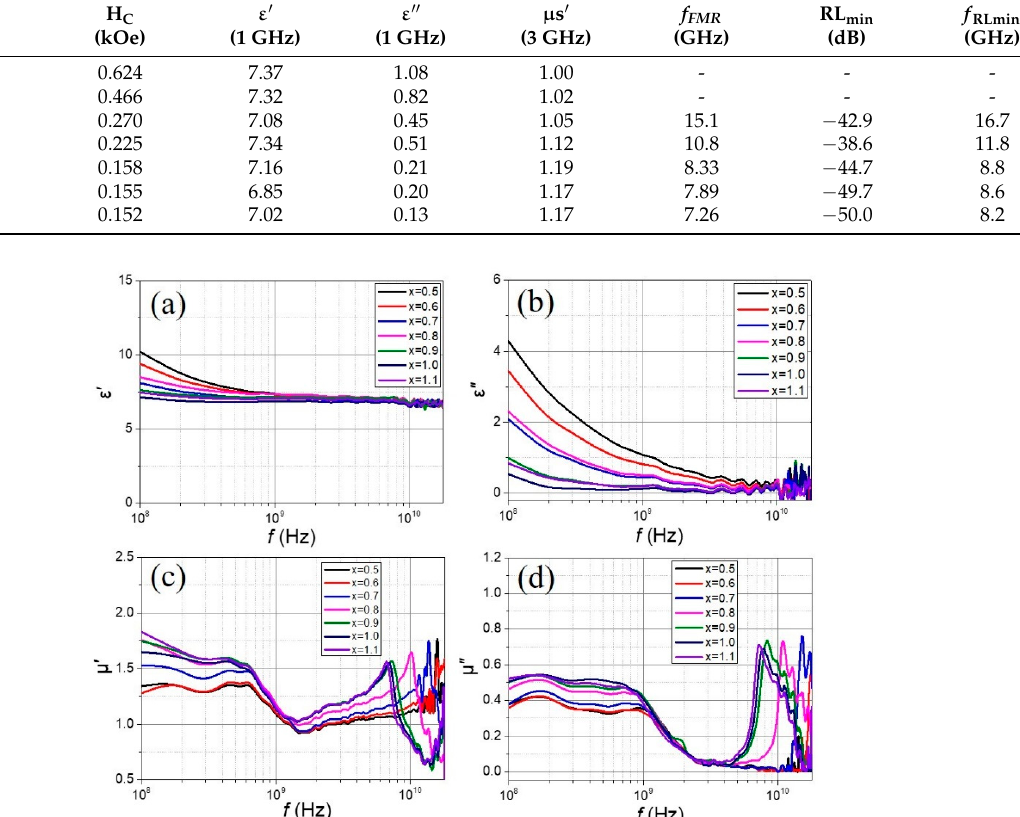
Table 2. Saturation magnetization (4 π M S ), coercivity (H C ), real ( ε (cid:48) ) and imaginary ( ε (cid:48)(cid:48) ) parts of permittivities at 1 GHz, real part of permeability ( µ s (cid:48) ) at steady region (at 3 GHz), frequencies of maximum µ (cid:48)(cid:48) values ( f FMR ), minimum RLs (RL min ), and frequencies of RL min ( f RLmin ) of SrFe 12 − 2x Zn x Zr x O 19 ( x = 0.5, 0.6, 0.7, 0.8, 0.9, 1.0, 1.1) powder–epoxy (10 wt%) composite samples.